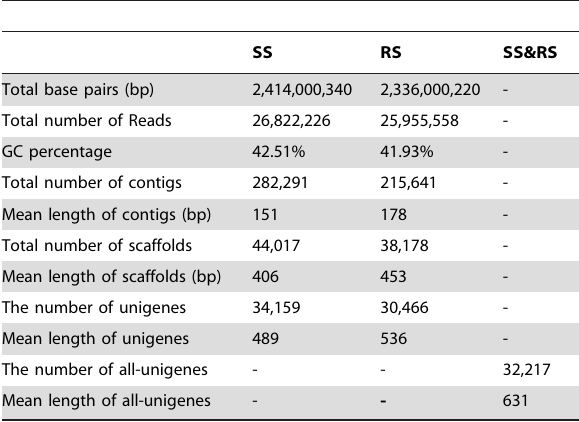
Table 1. Summary of reads in Susceptible Strains (SS) and Resistant Strains (RS) of Citrus red mite